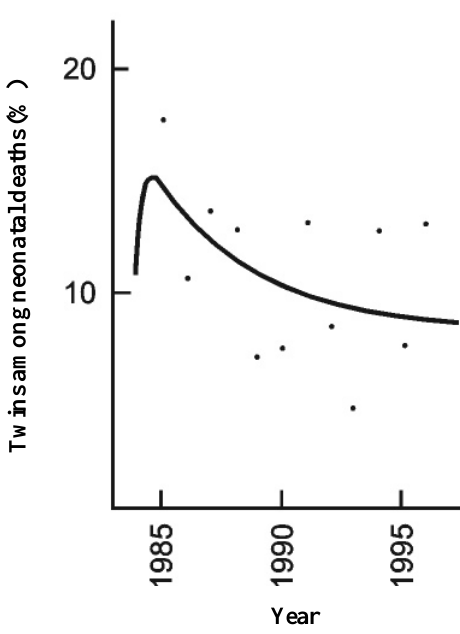
Figure 1 - Best fit regression curve for the annual distribution (1984-1996) of the percentage of twins among neonatal deaths ( y = 6.689 + 28.145 -